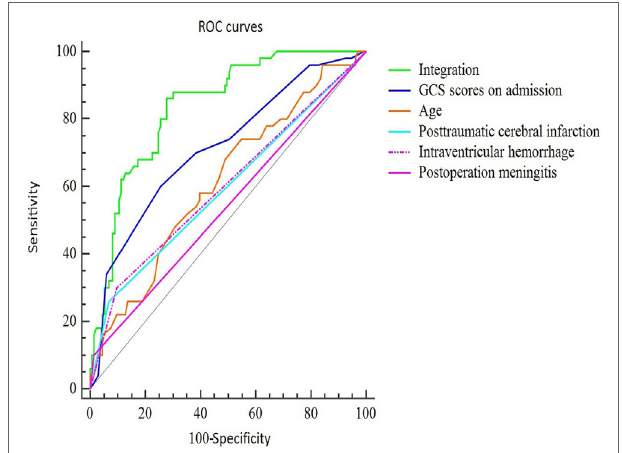
FigUre 1 | ROC curves of the final predictive model using five main risk factors. The sensitivity and specificity of the final combined curve were 0.86 and 0.72, respectively. Abbreviations: GCS, Glasgow Coma Scale; IVH, intraventricular hemorrhage; PCI, post-traumatic cerebral infarction.